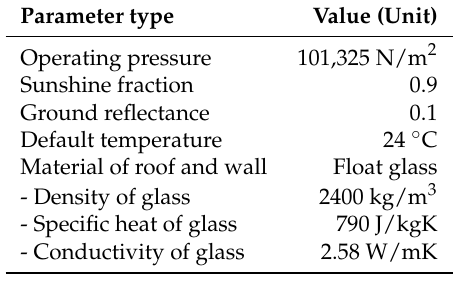
Table 1. The basic parameters setting for computational fluid dynamics (CFD) simulation.